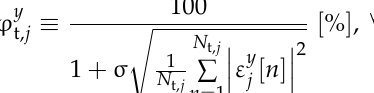
Figure 6. ( a ) Backward std variation. ( b ) Detection of transient time by means of A-R std.